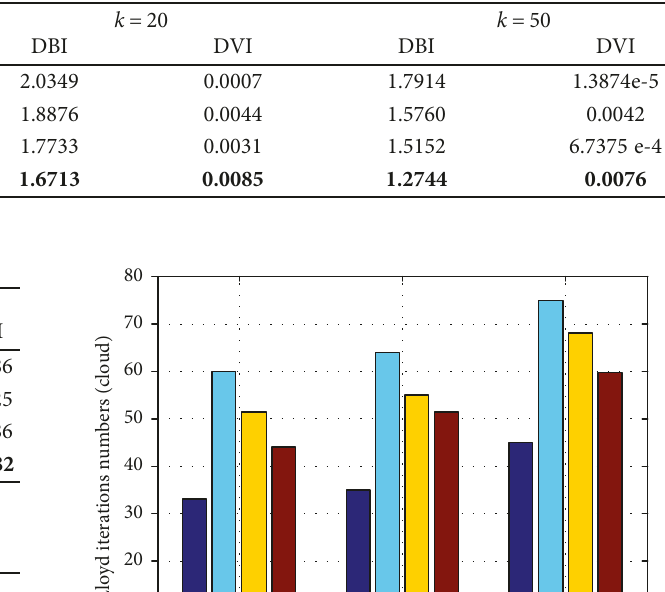
Table 7: Accuracy comparison (SPAM).